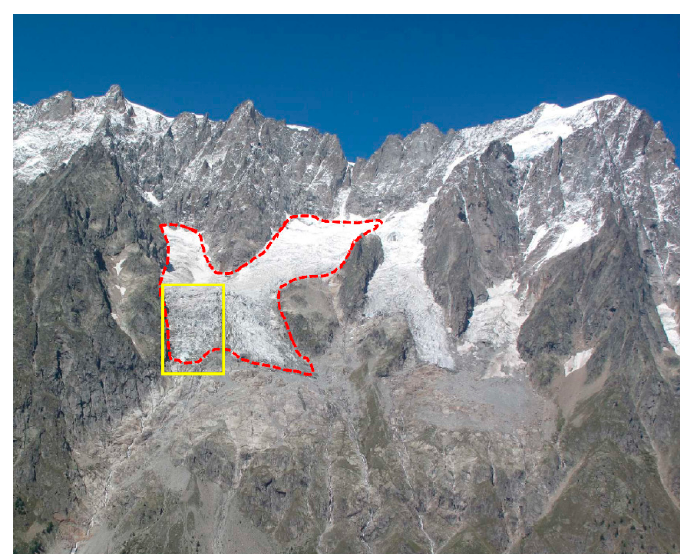
Figure 2. Overview of the Grandes Jorasses massif (northern sector of the Mount Blanc massif) with the Grandes Jorasses Glacier (on the right side of the image) and the Planpincieux Glacier (highlighted in dashed red line). The image was acquired by the webcam of the monitoring station. The yellow box indicates the part acquired by the ZOOM camera, which is the most active region of the Planpincieux glacier.